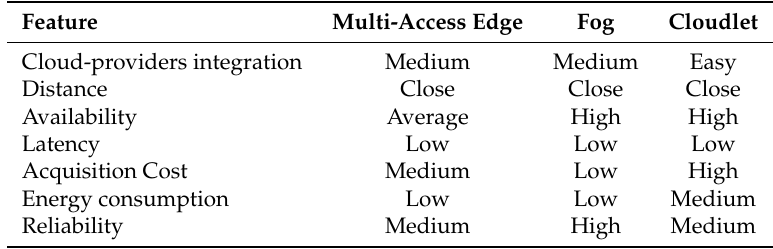
Table 1. Features summary for the edge-computing paradigms analysed. In this paper, we propose a model for the improvement of cost and energy consumption of cloudlet